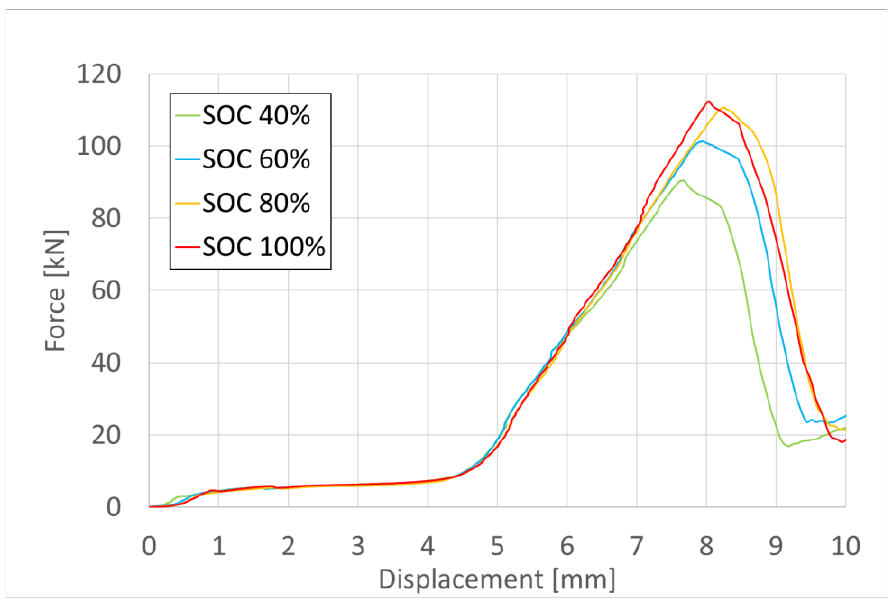
Figure 10. Force vs. displacement curves of experiments with different SoC at v = 10 mms −1 .